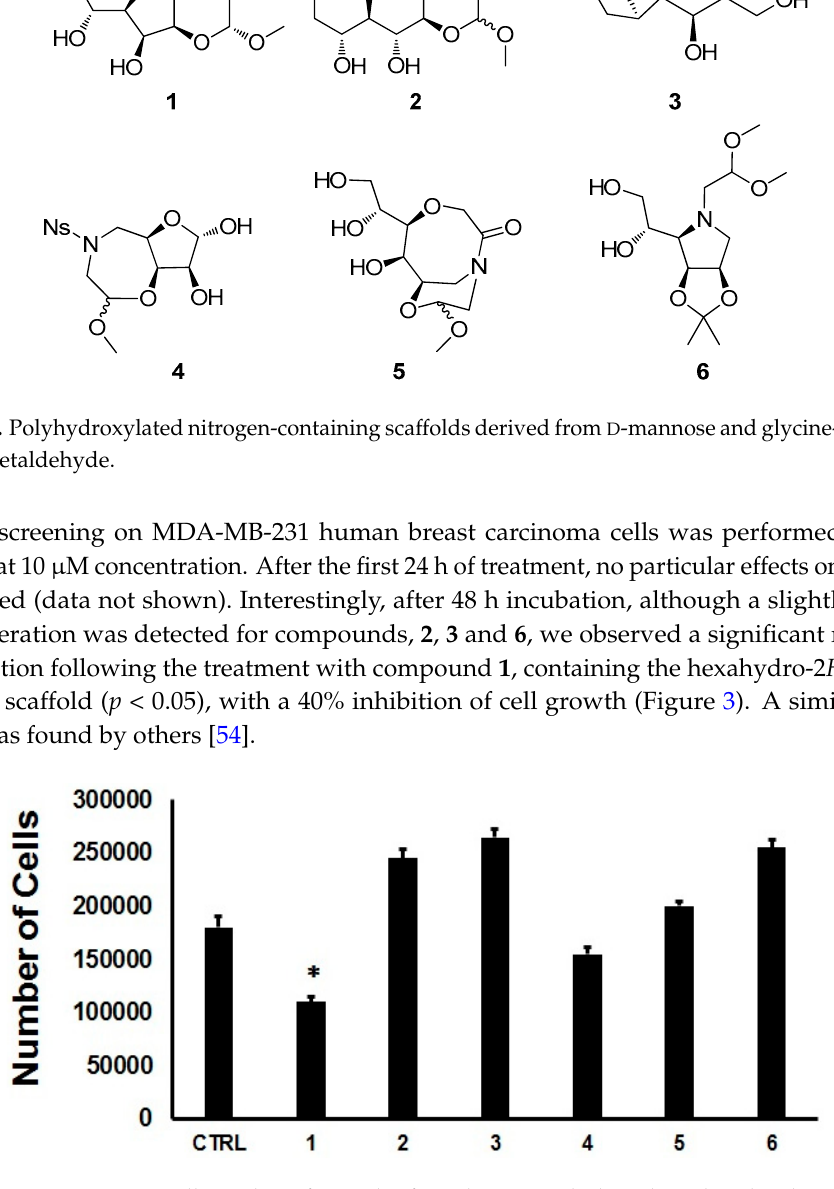
Figure 3. MDA-MB-231 cell number after 48 h of incubation with the selected molecules at 10 µ M concentration. Values correspond to the mean of three independent experiments. Error bars indicate the corresponding standard deviations values. Student’s t test was used to evaluate the data significance, * p < 0.05.